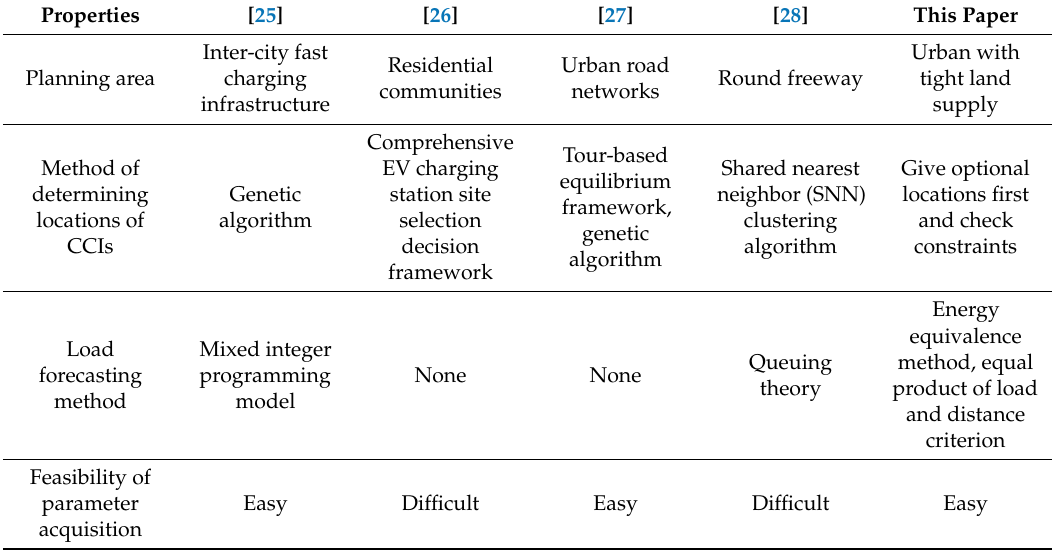
Table 1. Comparison with several related